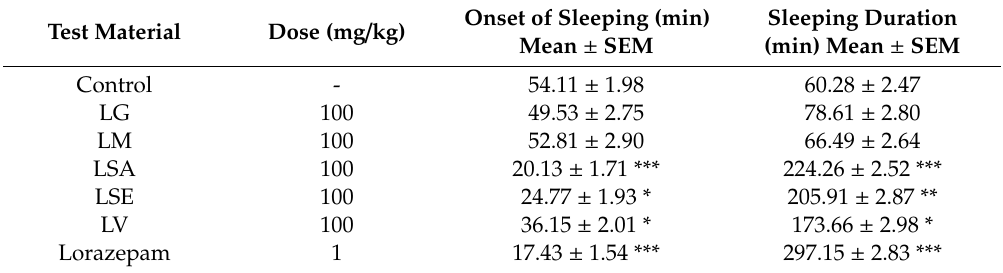
Table 2. Sedative e ff ects of test materials determined by the thiopental-induced sleeping